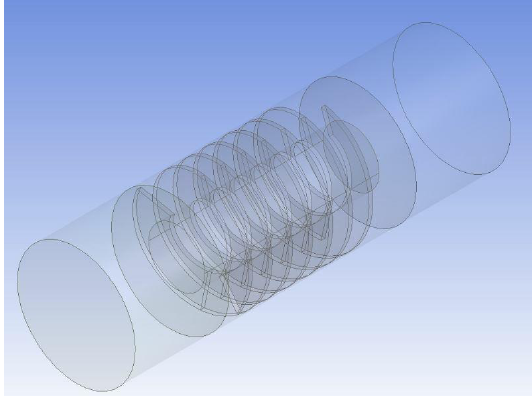
Figure 8. ANSYS Fluent modeling.